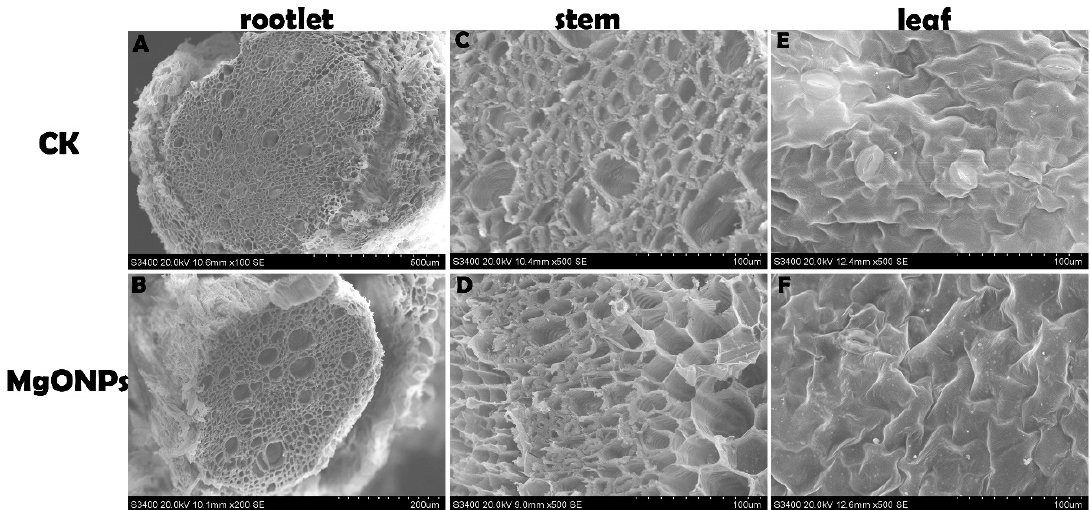
Figure 5. Morphological interactions with or without MgONPs treatment on 30 days using SEM analysis. ( A , B ) rootlet, ( C , D ) stem, ( E , F )